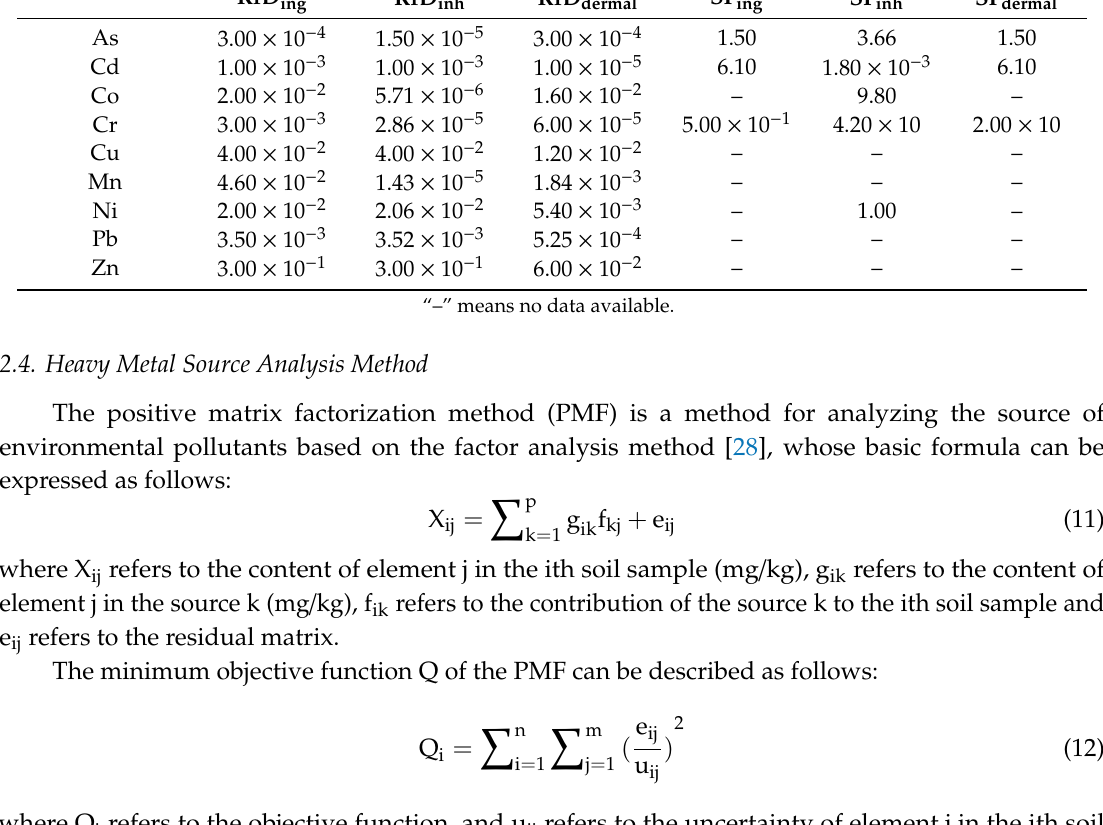
Table 5. Reference dose and slope factors of heavy metals for di ff erent exposure pathways. Reference Dose (RfD) Slope Factors (SF) Heavy Metals RfD ing RfD inh RfD dermal